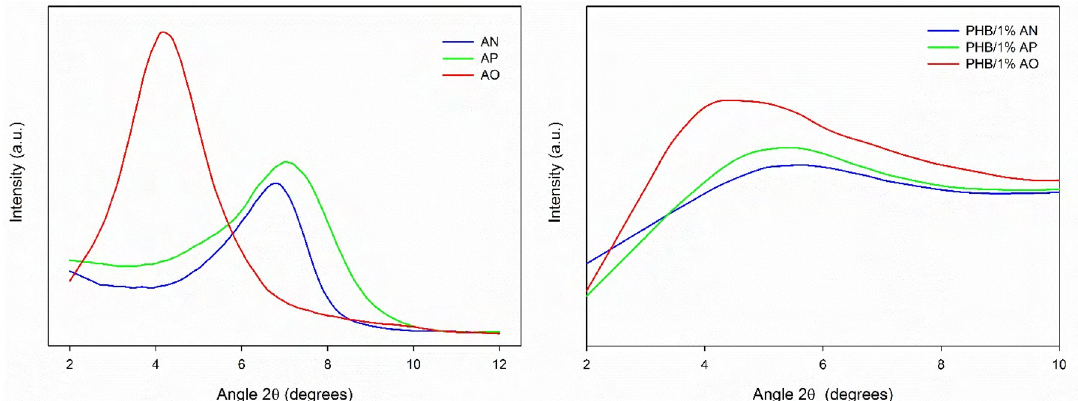
Figure 3. X-Ray difractograms of natural (AN), purified (AP) and purified/organophilic (AO) Bentonite clays (left) and, for PHB compounds with 1% of these clays (right).